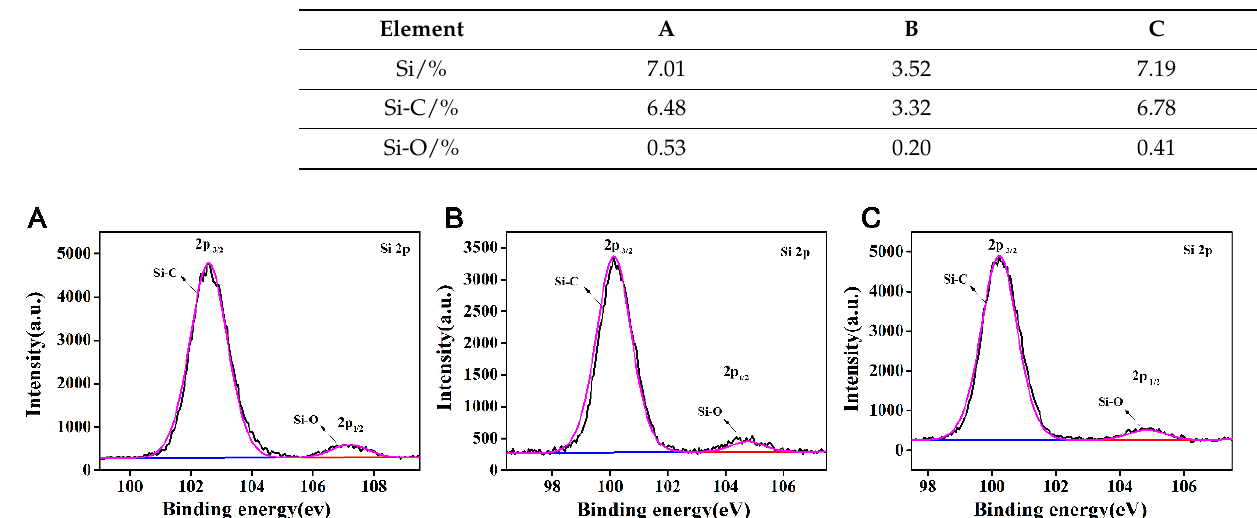
Figure 8. XPS silicon spectrum of EP-POSS with inorganic nanoparticles. ( A ) EP-POSS/SiO 2 /graphene, ( B ) EP-POSS/ZnO/graphene, ( C ) EP-POSS/graphene. Table 1. Surface silicon content of EP-POSS after adding inorganic nanoparticles. ( A ) EP-